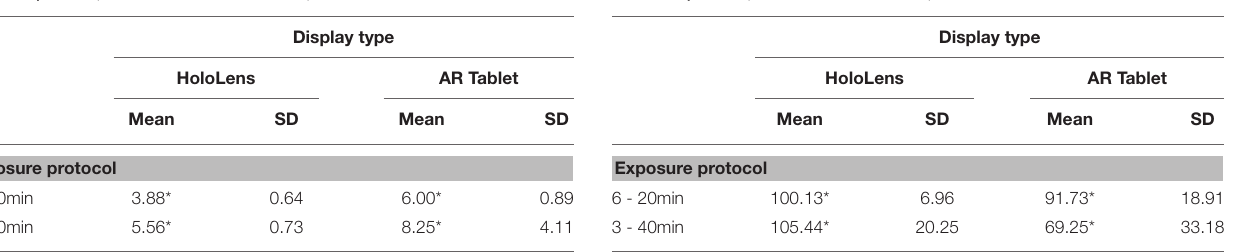
TABLE 3 | TCCC performance scenarios completed. TABLE 4 | TCCC performance correct